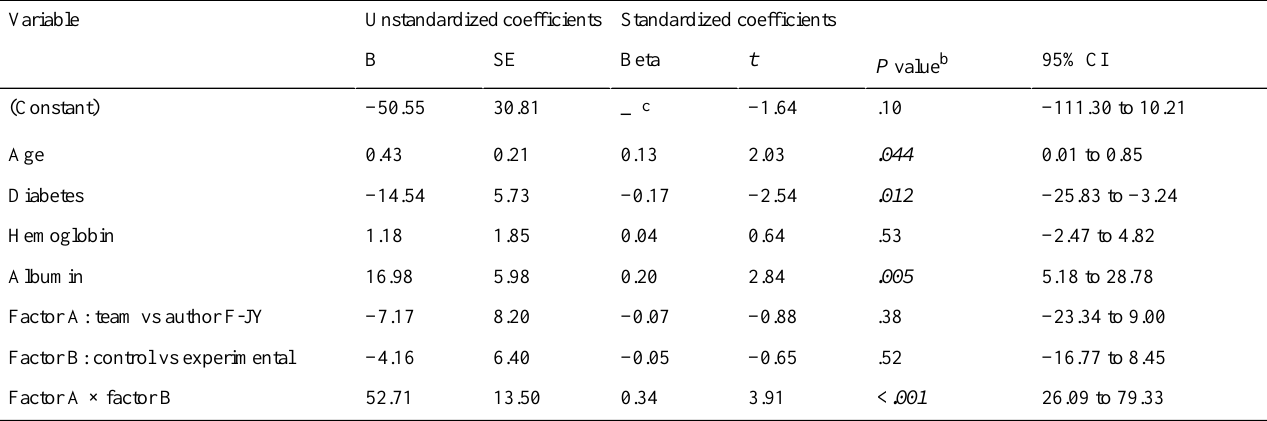
Table 5. Associations between the duration of each drop in estimated glomerular filtration rate and the care model using difference in differences a